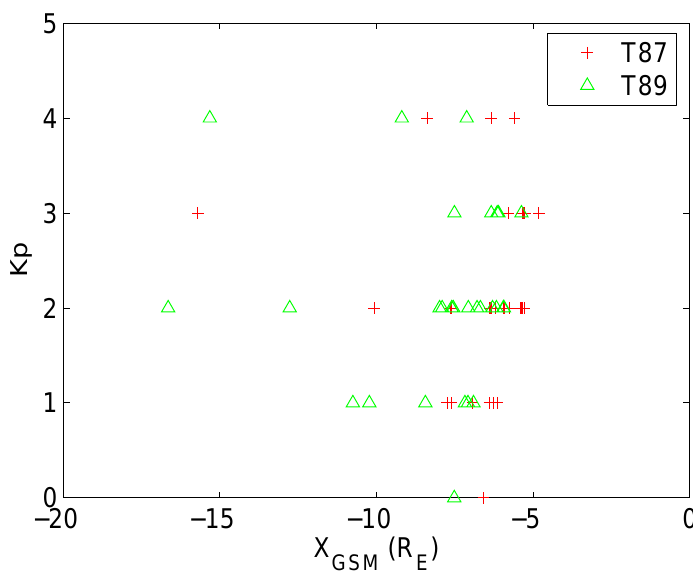
Fig. 7. Dependence of onset location versus K p